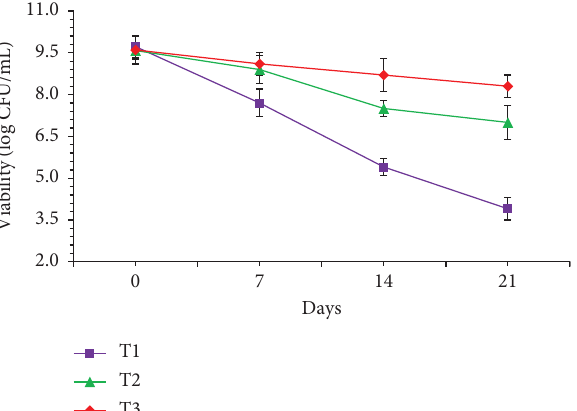
� free L. rhamnosus ; 1